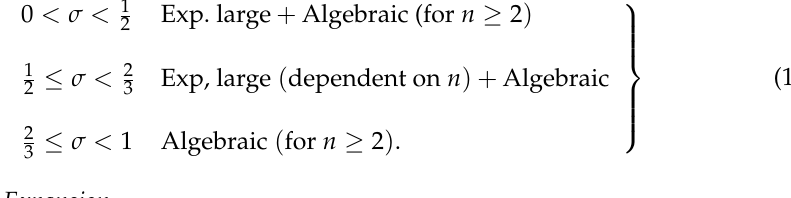
πσ ω r for πσ ω r for ± − ± −